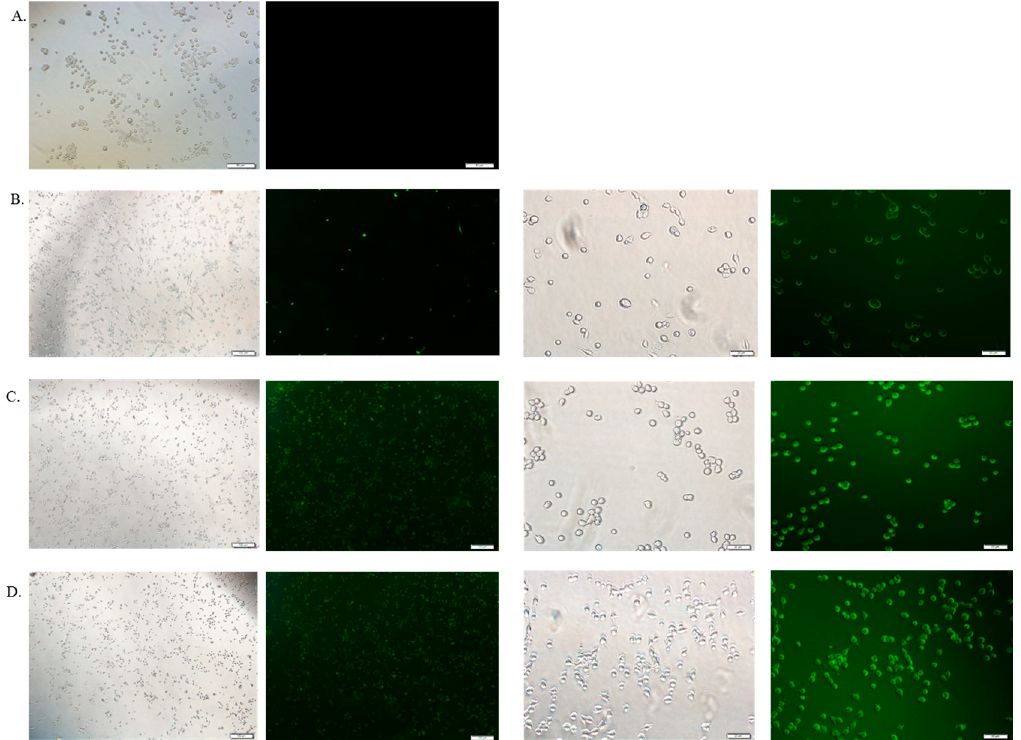
Figure 9. Fluorescence image analysis of MCF-7 cells incubated with media only ( A ), DOX 1 µM ( B ) , DOX-loaded CA NPs (1 µM) ( C ) and DOX-loaded CMCA NPs (1µM) ( D ) at 37 °C for 1 h with 4× and 20× magnifications at a scale bar of 100 µm and 20 µm.